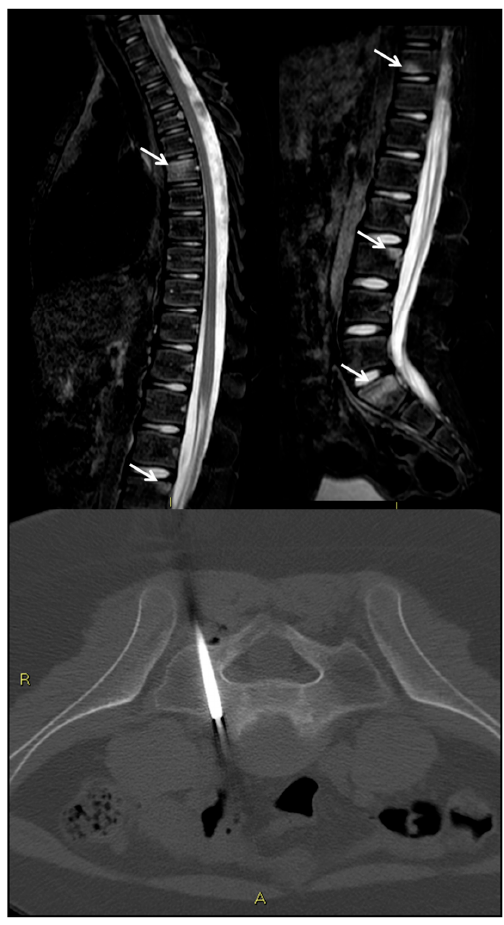
Figure 7. Chronic recurrent multifocal osteomyelitis (CRMO) in an 11-year-old boy. MRI shows several areas of bone edema in thoracic, lumbar, and sacral vertebral bodies (arrows). After a CT-guided bone biopsy of S1, the diagnosis of exclusion was CRMO.